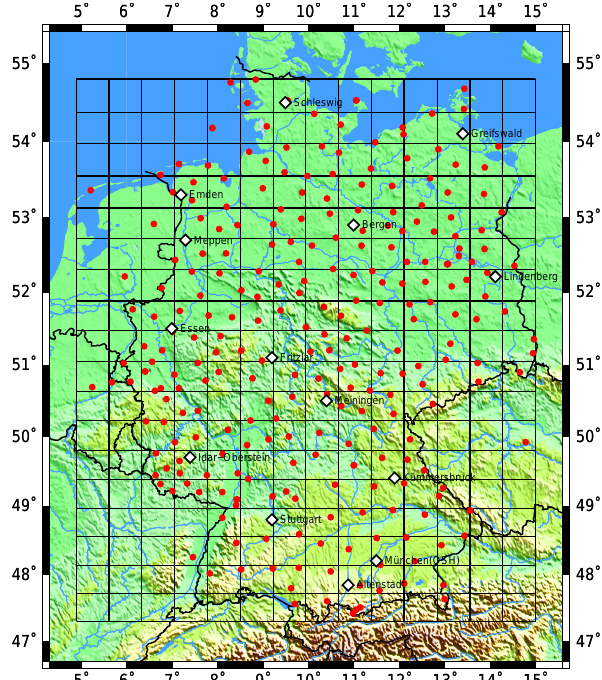
Fig. 1. Location of the 272 GPS receiver sites (red dots) inside the tomography grid (black) and the German radiosonde stations (white rhombs). There were no data for station Altenstadt in the year 2007. A 14 × 18 × 20 cell grid was chosen for the